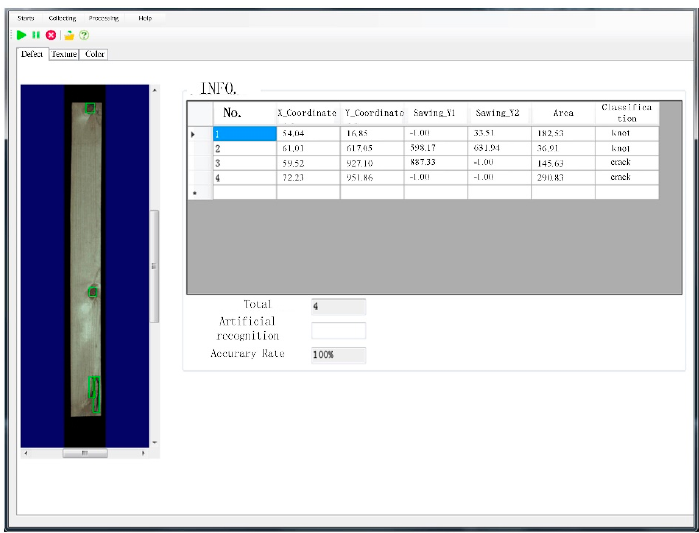
Figure 11. System interface diagram based on depth learning.